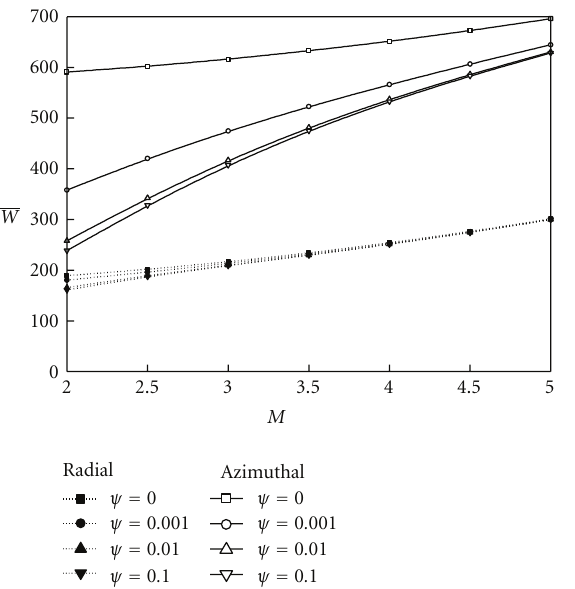
Figure 11: Variation of nondimensional response time t with 1 − h m for di ff erent values of l with β = 0 . 05, M = 2, c = 0 . 3, and ψ = 0 .